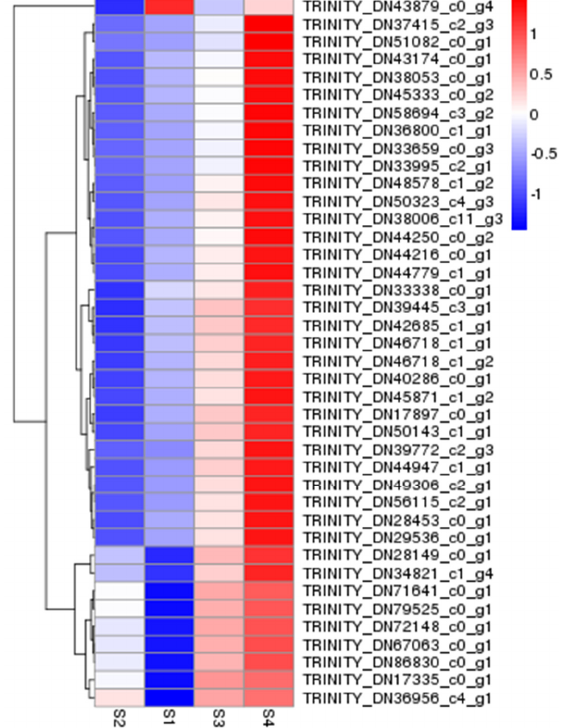
Figure 2. Clustering heatmap of 40 common differentially expressed genes in four periods S1-S4. S1-S4 represent different periods of A. phaeospermum infection B. pervariabilis × D. grandis. Blue represents low gene expression, and the darker the color, the lower the expression. Red represents high gene expression, and the darker the color, the higher the expression.